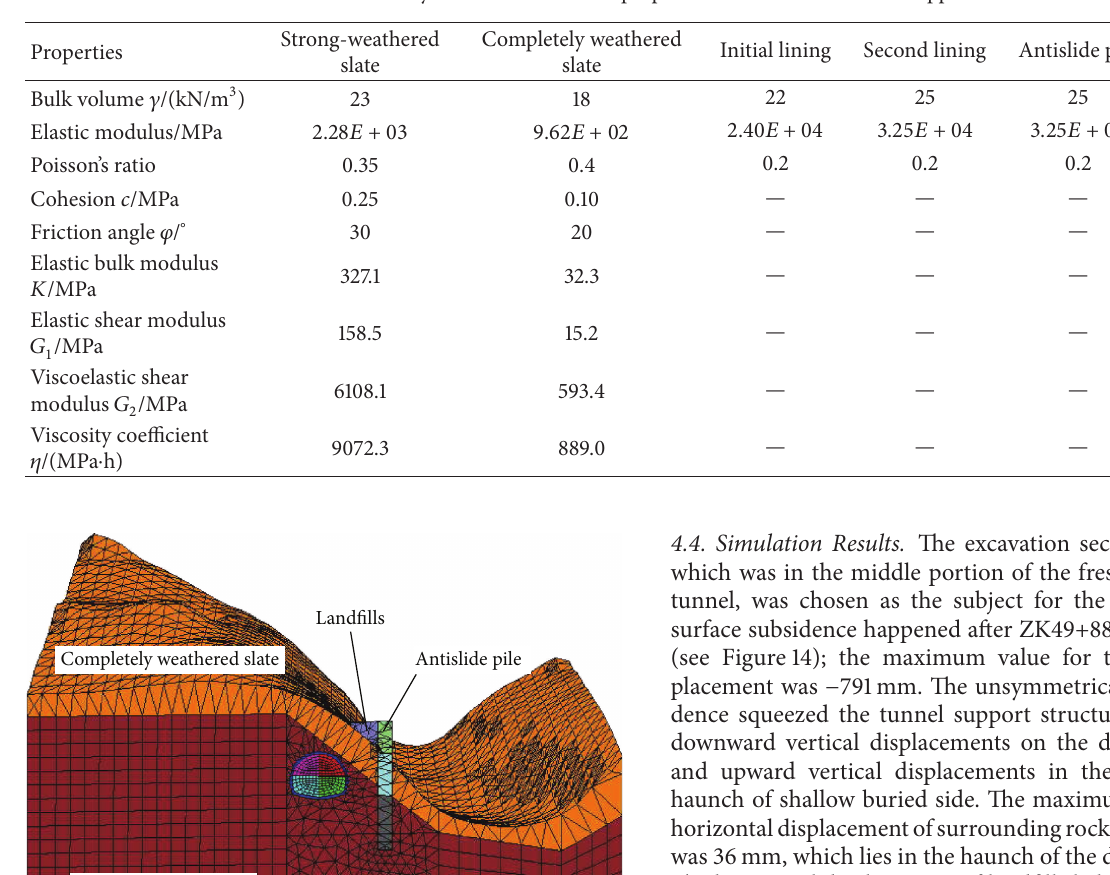
Table 3: Physical and mechanical properties of the rock mass and support.